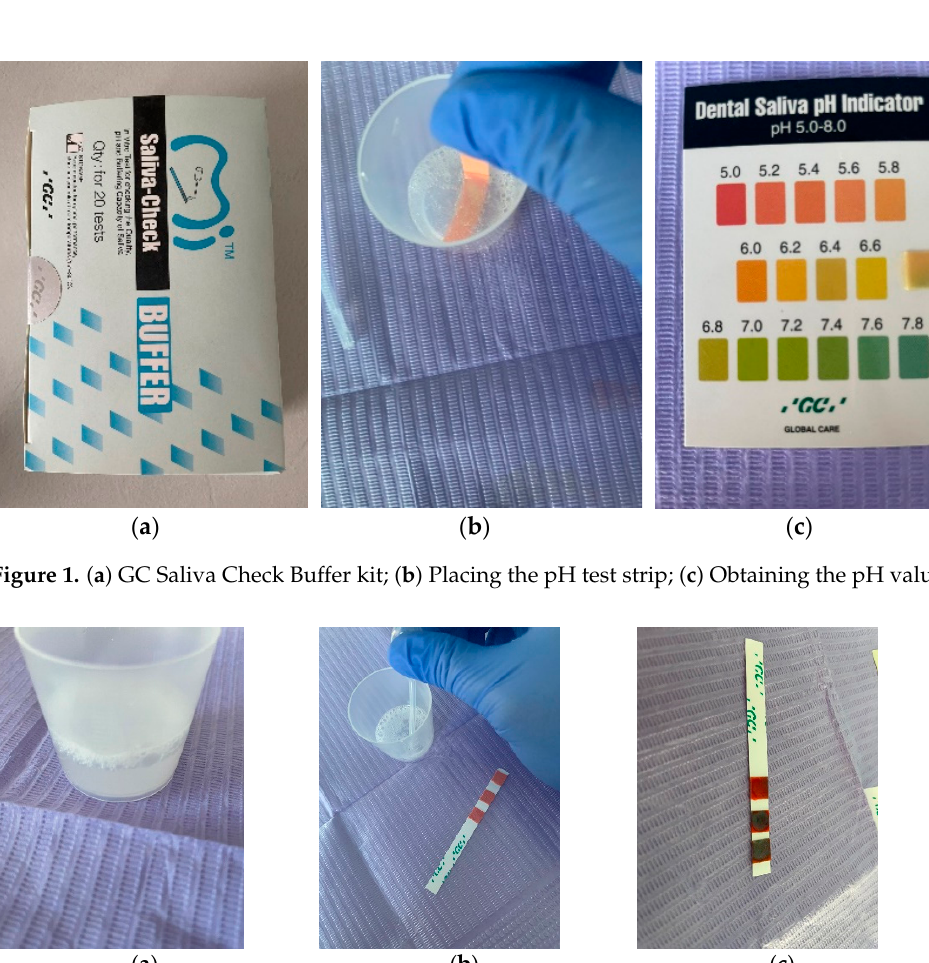
Figure 2. ( a ) Saliva collected in the dispensing cup; ( b ) Use of a pipette to apply saliva to the test strip; ( c ) Buffer test value = 8, low salivary buffer capacity.